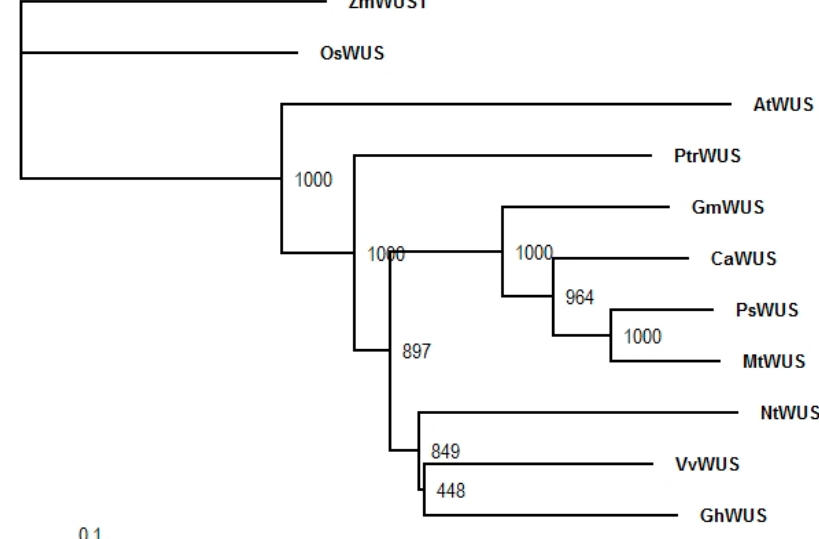
Figure 1. Neighbor Joining phylogenetic tree for WUS protein sequences in Pisum sativum L. and related species. Bootstraps values were generated with 1000 bootstrap replicates. The tree was rooted using the Zea mays WUS (ZmWUS1) protein sequence.